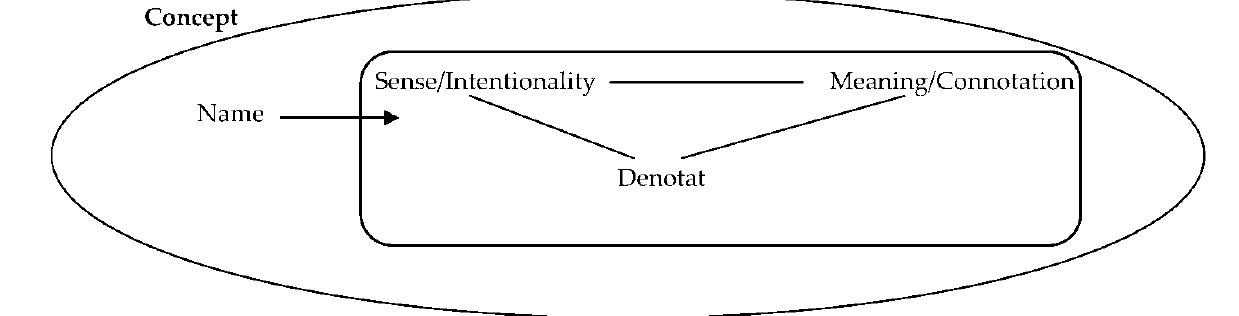
Figure 1. The extended Peircean model of a concept.